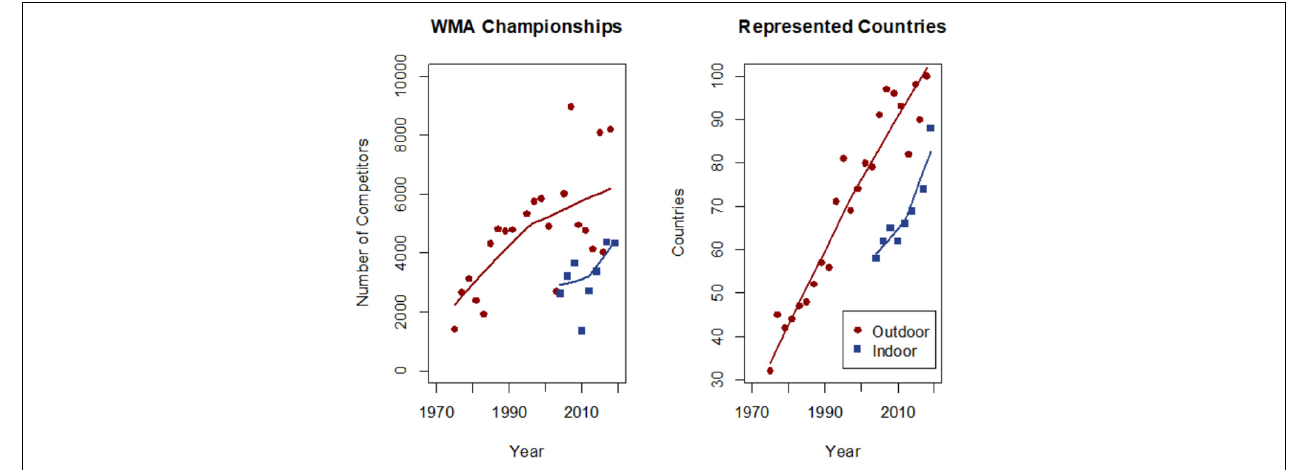
FIGURE 1 | Participation in world masters athletics championship in the past 4 decades, quantified by the number of competing athletes (left) and by the number of countries represented (right). Data are courtesy by the World Master Athletics (WMA).